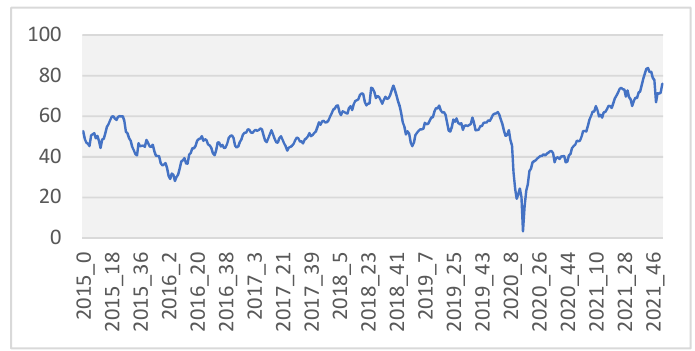
Figure 10. WTI Spot Price (Dollars/Barrel).